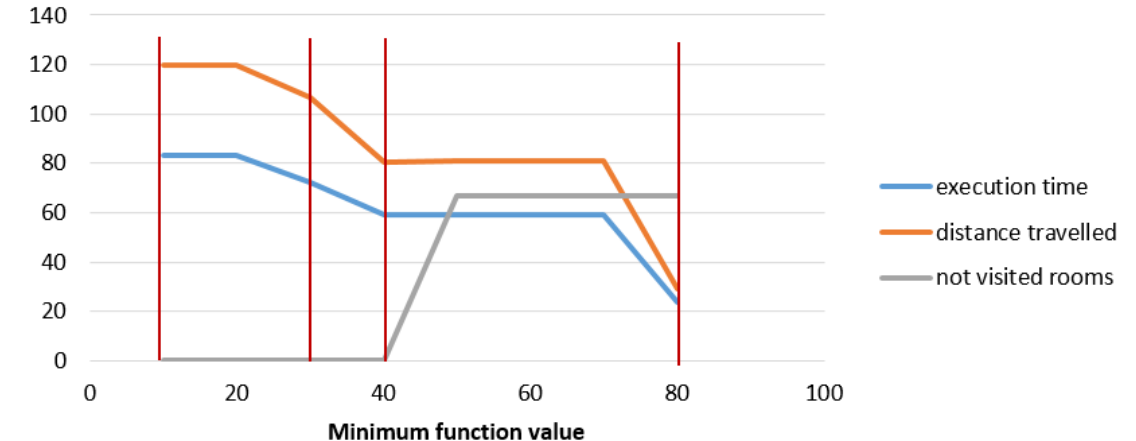
Figure 7. Comparison of the topological maps obtained for the different minimum interesting values ( x -axis for the function value and y -axis for the metrics): traveled distance (m), execution time (min) and percentage of non-visited